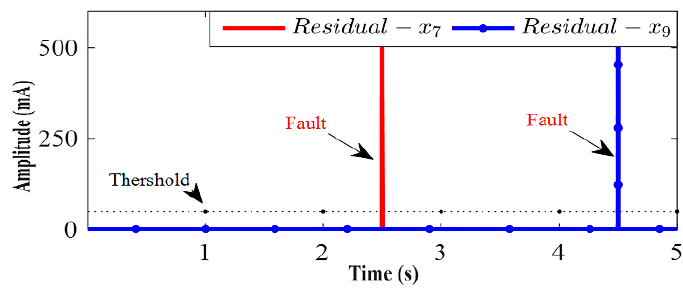
Figure 16. Residual current of C 7 and C 9 capacitors during fault occurrence.